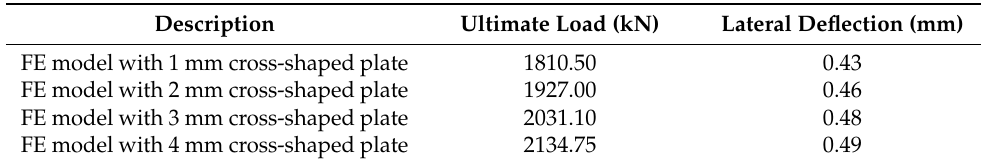
Table 6. Summary of ultimate load-bearing capacity and lateral deflection of the FE models of SCFST with different thickness of the cross-shaped